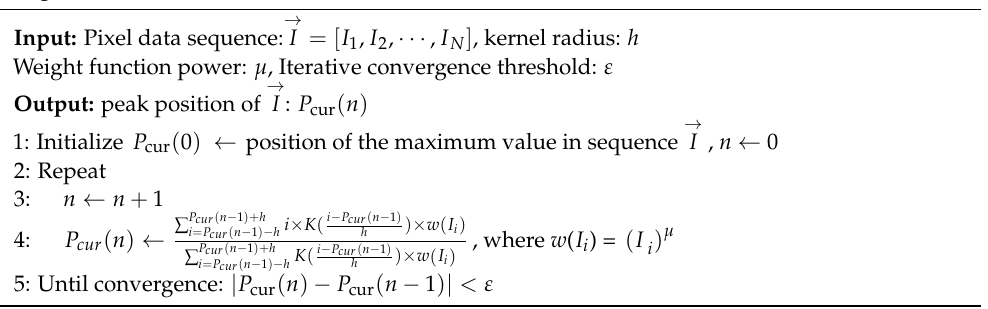
Algorithm 1. Mean-shift based extraction with the novel kernel